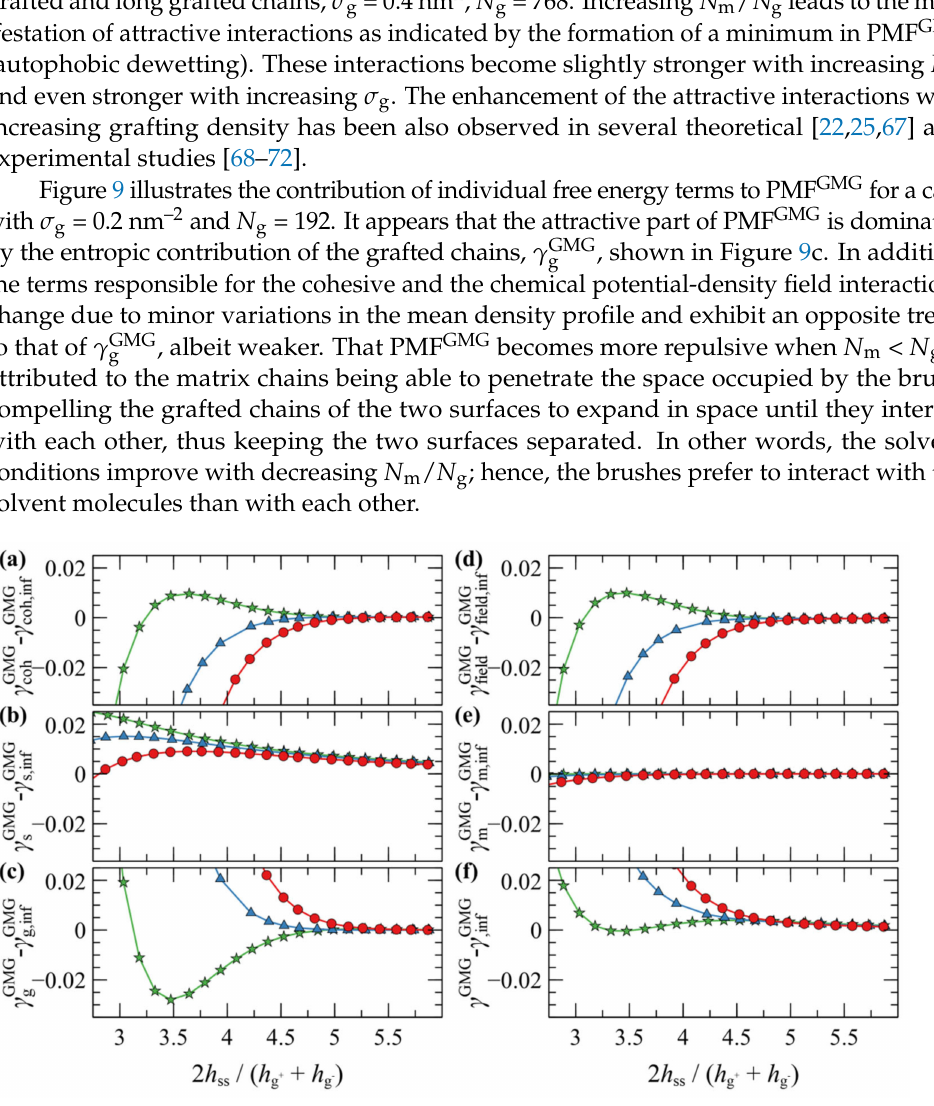
Figure 9. Free energy partial contributions to the potential of mean force, in mJ/m 2 , of two ap- proaching symmetric grafted surfaces with σ g = 0.2 nm –2 and N g = 192 embedded in a melt with N m / N g = 0.5 (circles), 1 (triangles) and 2 (stars): ( a ) cohesive interactions, ( b ) polymer-solid in- teractions, ( c ) entropic contribution from grafted chains, ( d ) density-field interactions, ( e ) entropic contributions of matrix chains and ( f ) total grand